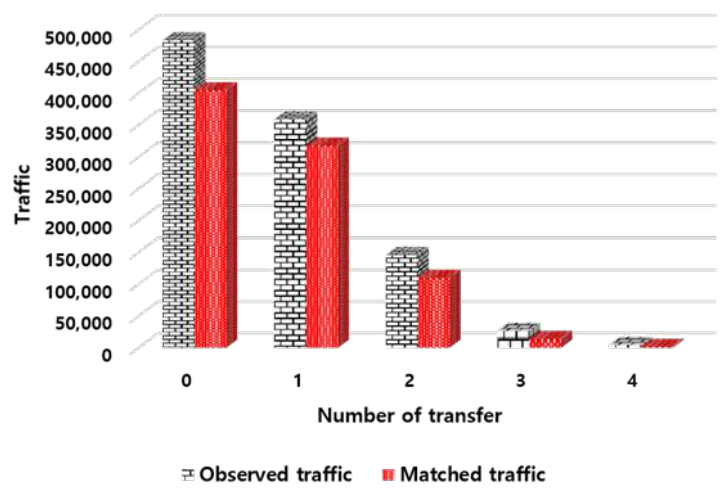
Figure 7. Matching rate by number of transfers on the route. The ridership numbers on bus No. 1167 and the Ui-Sinseol subway line